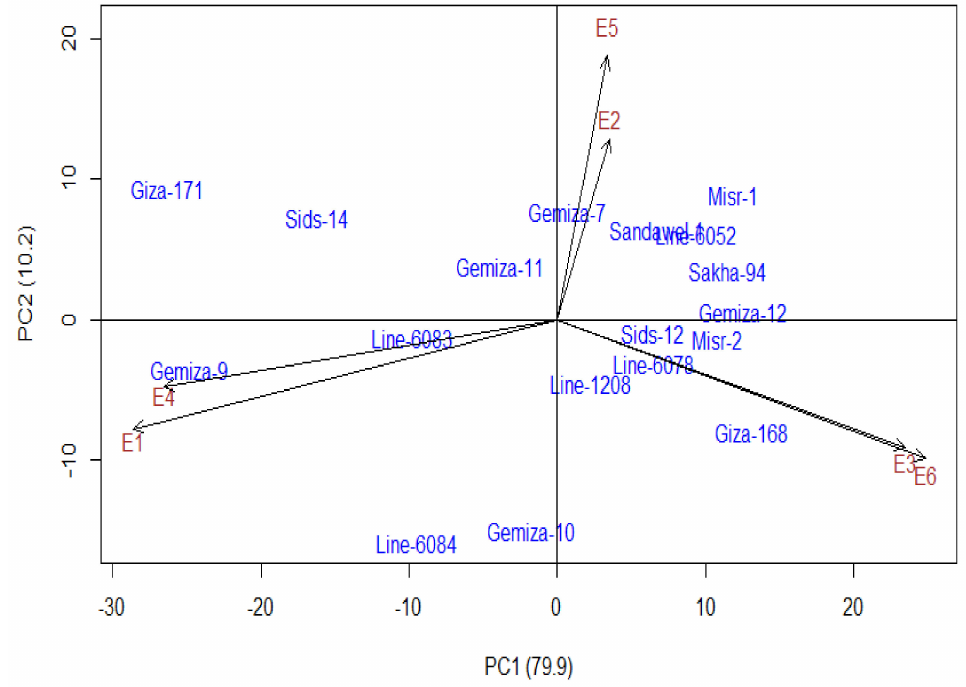
Figure 1. Additive main e ff ect and multiplicative interaction (AMMI) biplot for grain yield of 18 wheat genotypes evaluated in six environments. E1 and E4 are low salinity level (5.25 dS m − 1 in the two growing seasons), E2 and E5 are moderate salinity level (8.35 dS m − 1 in the two growing seasons), and E3 and E6 are high salinity level (11.12 dS m − 1 in the two growing